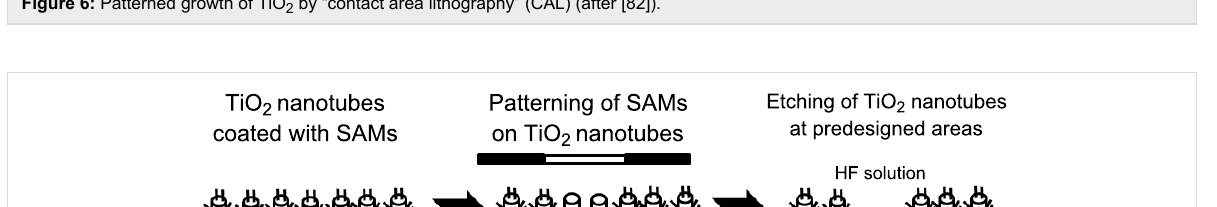
Figure 6: Patterned growth of TiO 2 by “contact area lithography” (CAL) (after [82]).